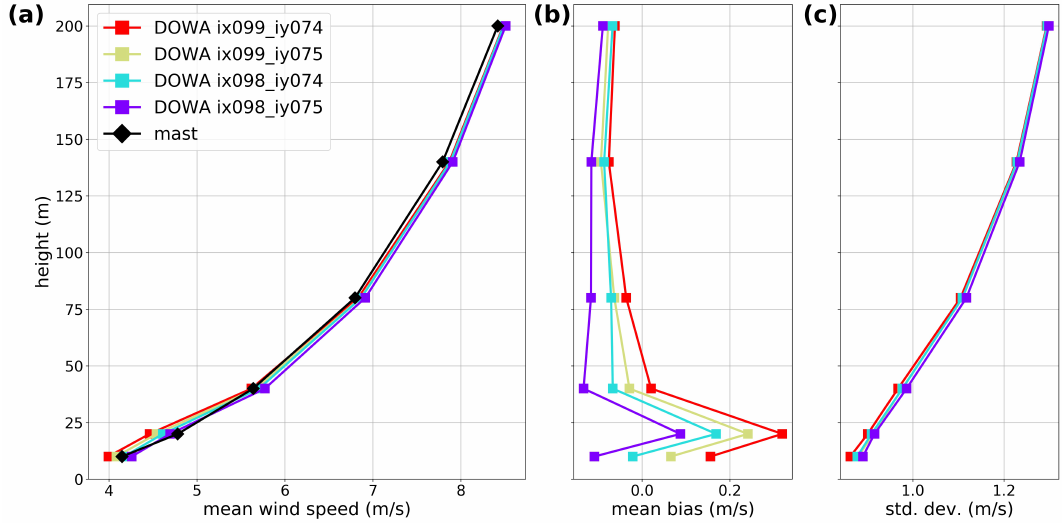
Figure A4. Height profile of ( a ) the mean wind speed, ( b ) mean bias, and ( c ) standard deviation of the bias, showing mast measurements (black) and the four nearest grid points of DOWA.